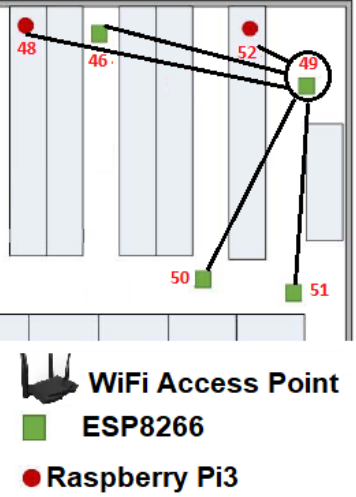
Figure 11. List of reliable nodes of the MCU 49 ( t 0 ) , i.e., LNR 49 ( t 0 )